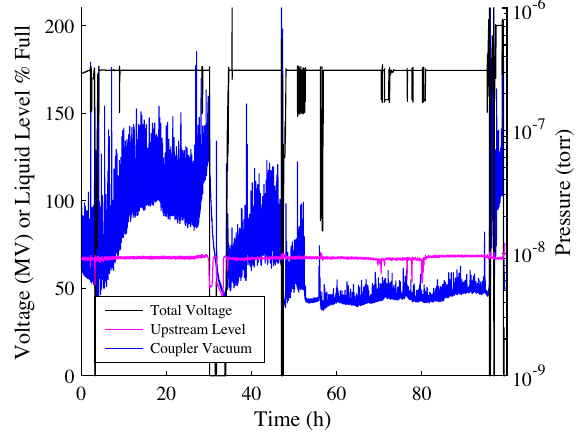
FIG. 19. Cryomodule voltage, upstream liquid level and cou- pler pressure over four days during the unit test. The decrease in the coupler vacuum pressure over time was due in part to Q adjustments that lowered the rf input power.